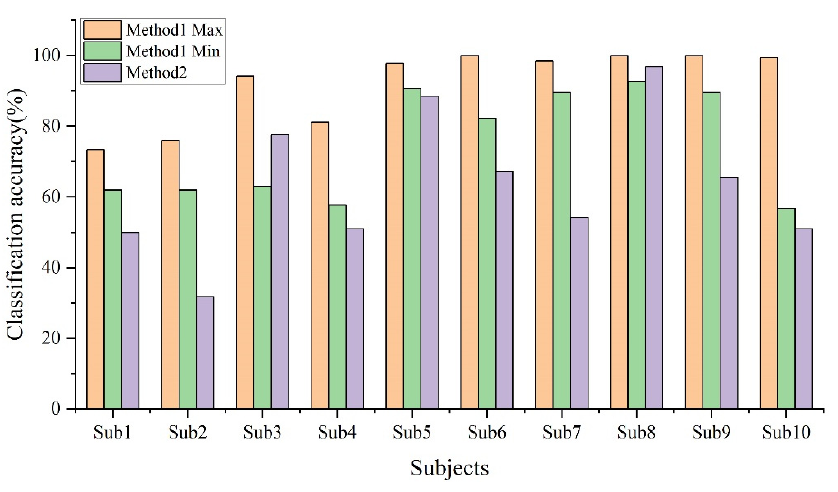
Figure 9. Classification accuracy comparison of Method 1 and Method 2.